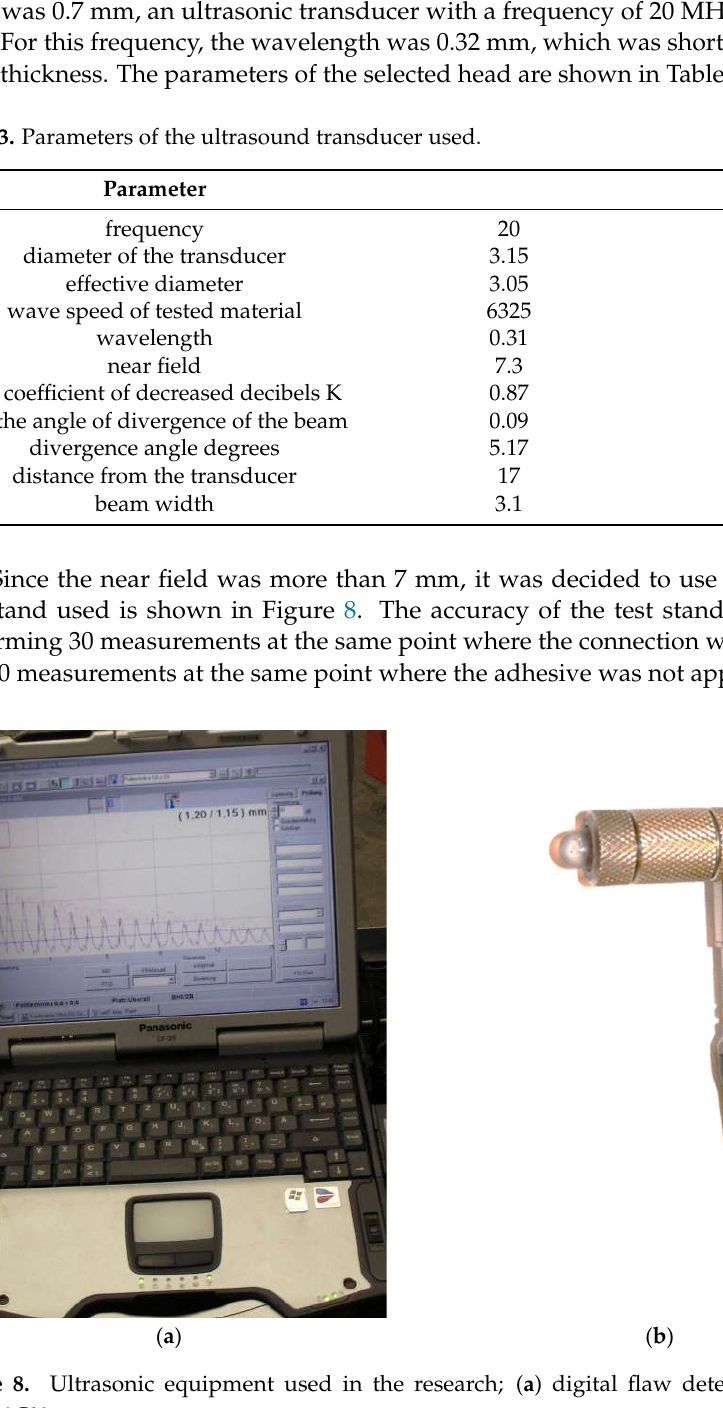
Figure 9. Ultrasonic testing; 1—ultrasonic probe; 2—stell DC01; 3—adhesive; 4—ultrasonic flaw de- tector screen; 5—first echo on the flaw detector screen (in this case H I = 80 %); 6—second echo on the flaw detector screen (in this case H II = 40 %); 7—third echo on the flaw detector screen (in this case H III = 9 %). 2.5. Strength Tests The strength tests were carried out using A Cometech B1/E testing machine (Come- tech Testing Machines Co., Taichung, Taiwan)—Figure 10. During the work, the maxi- mum load of the tested joints was recorded.